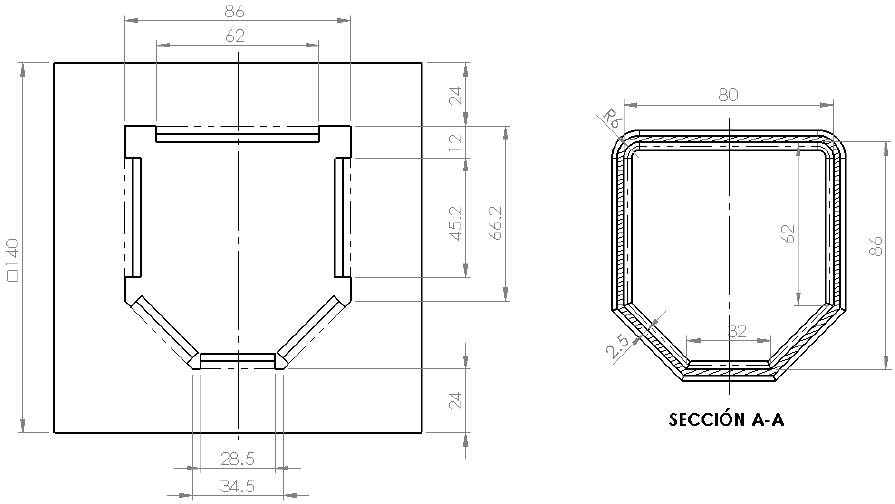
Figure 6. Frontal view of flange and frame rail.